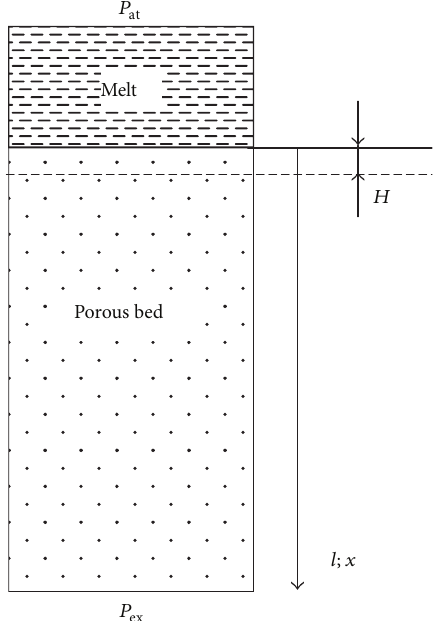
Figure 2: Principal scheme of NaCl porous bed